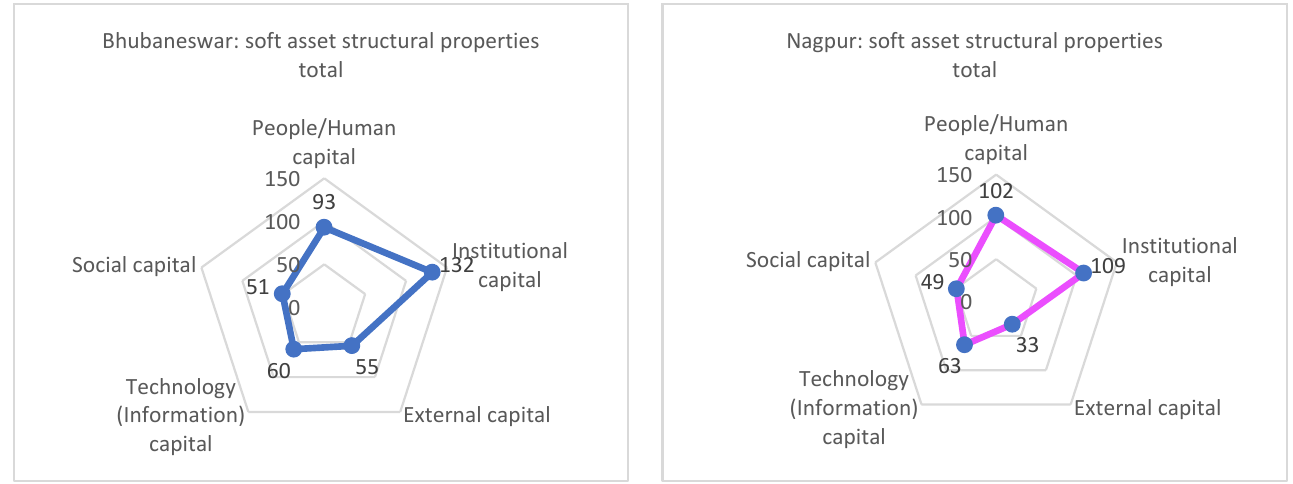
Figure 4. Total number of soft assets considerations for five soft asset capitals.